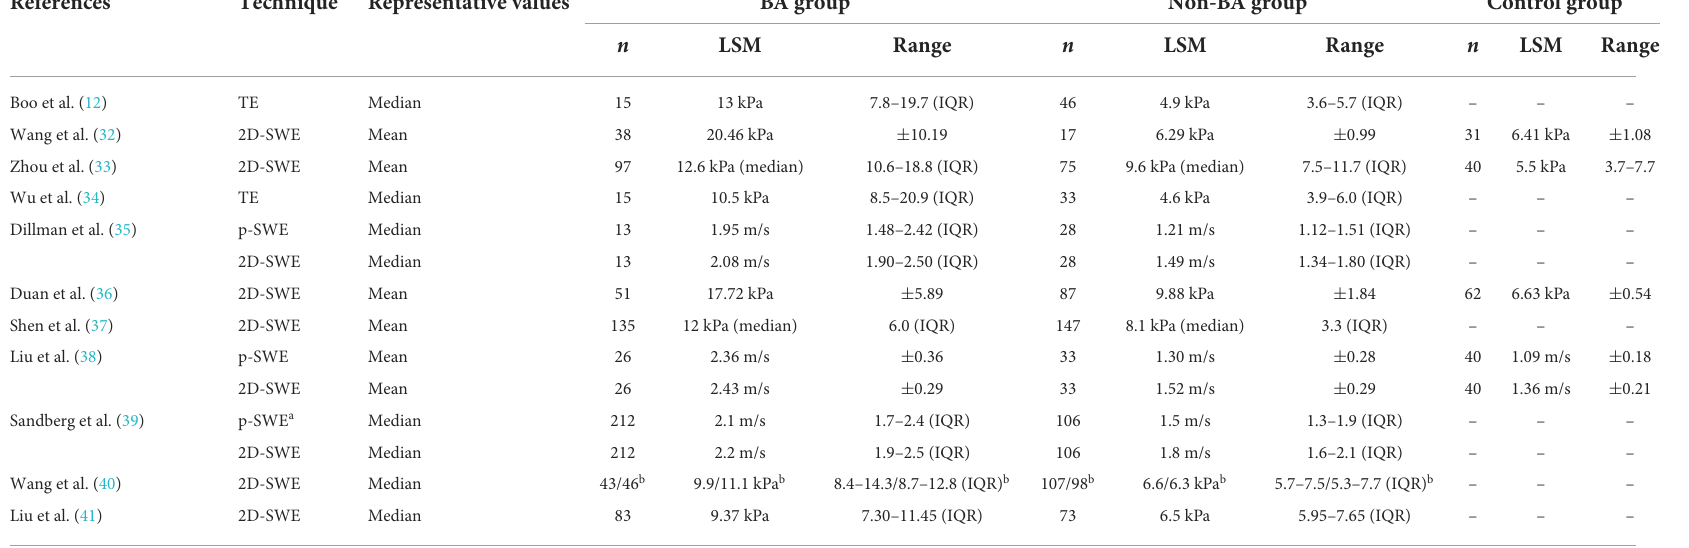
TABLE 3 The LSM of infants in different groups in the included